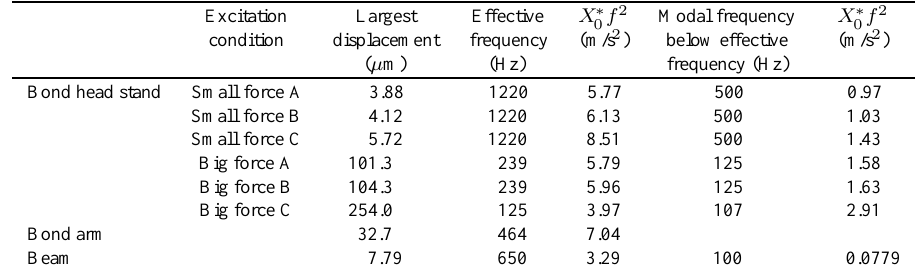
Table 4 Accelerations of the effective